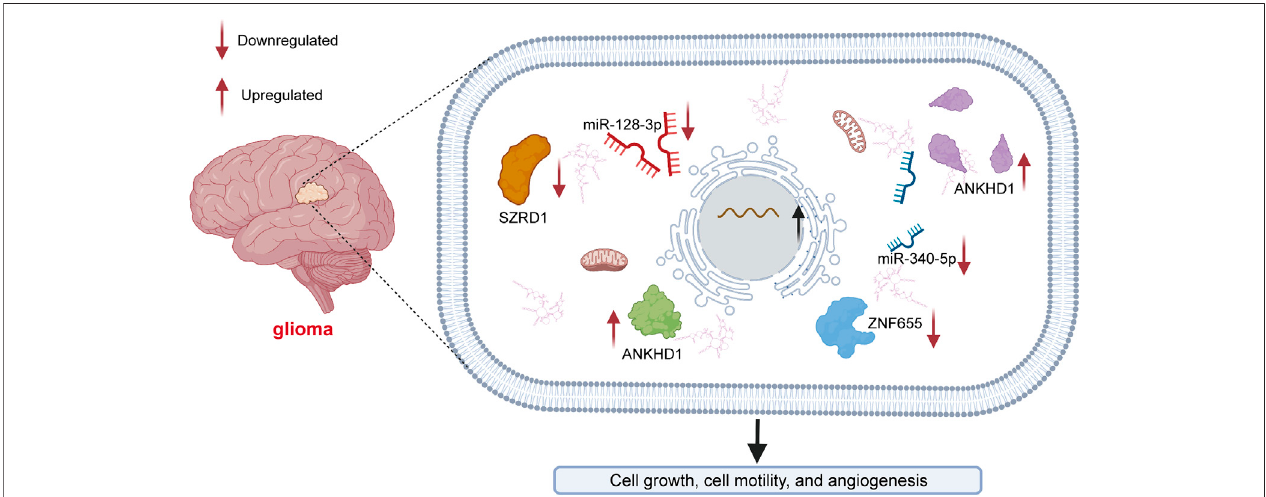
FIGURE 2 | Mechanisms of LINC00346 in glioma. LINC00346 upregulates SZRD1 levels by sponging miR-128-3p in glioma. LINC00346 modulates cell proliferationandapoptosisbyregulatingmiR-128-3p/SZRD1.LINC00346alsofunctionsasaceRNAofmiR-340-5p toreducetheexpressionlevelofROCK1inglioma. The expression level of LINC00346 is positively regulated by ankyrin repeat and KH domain-containing protein 1 (ANKHD1). Angiogenesis associated with glioma- associated endothelial cells (GECs) is facilitated by the ANKHD1/LINC00346/znf655 pathway.